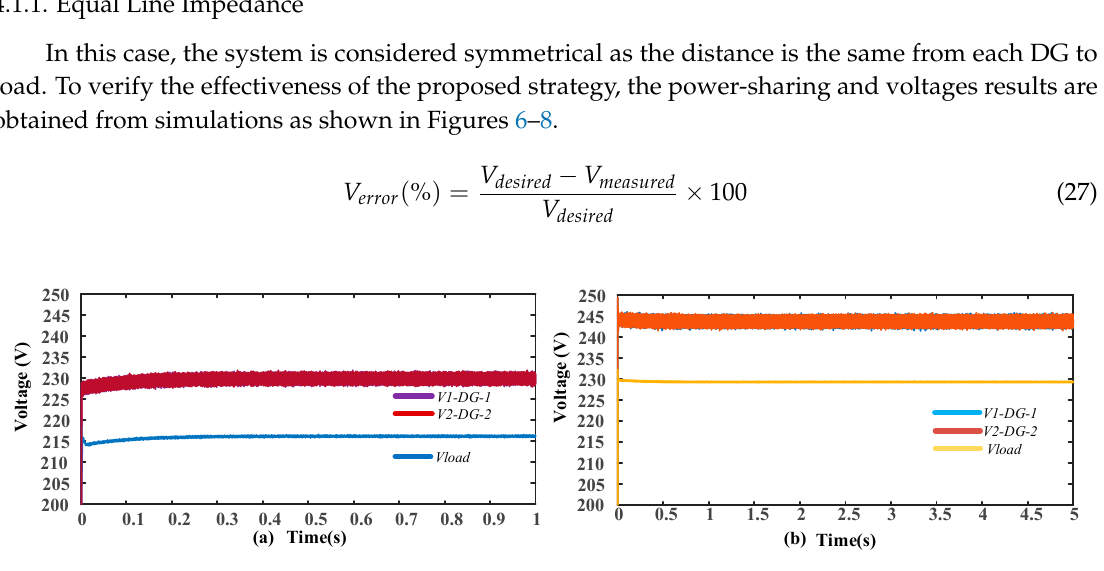
Figure 6. ( a ) Inverter terminal and load voltages for the conventional control scheme; ( b ) inverter terminal and load voltages for proposed control scheme.